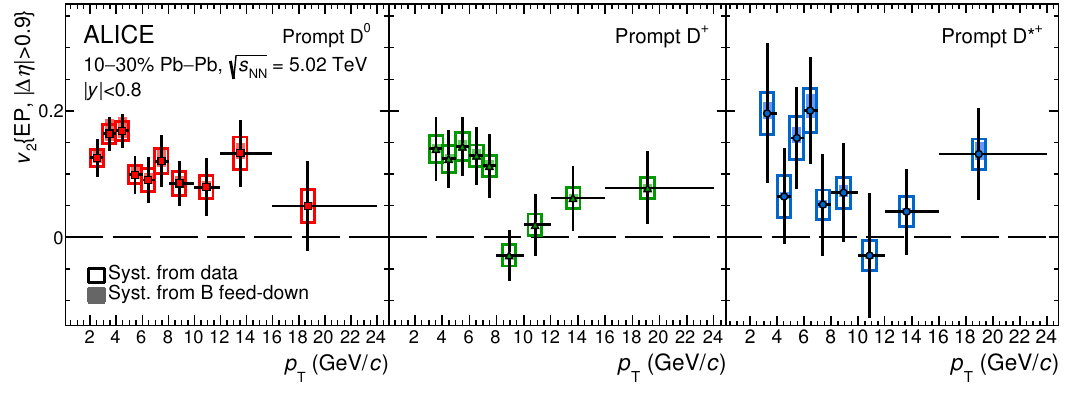
Figure 5 . Elliptic (cid:13)ow coe(cid:14)cient v 2 as a function of p T for prompt D 0 , D + , and D (cid:3) + mesons p for Pb-Pb collisions at s = 5 : 02 TeV in the centrality class 10{30%. The symbols are posi- NN tioned horizontally at the average p T of the reconstructed D mesons. Vertical error bars represent the statistical uncertainty, empty boxes the systematic uncertainty associated with the D-meson anisotropy measurement and the event-plane resolution. Shaded boxes show the uncertainty due to the feed-down from beauty-hadron decays.